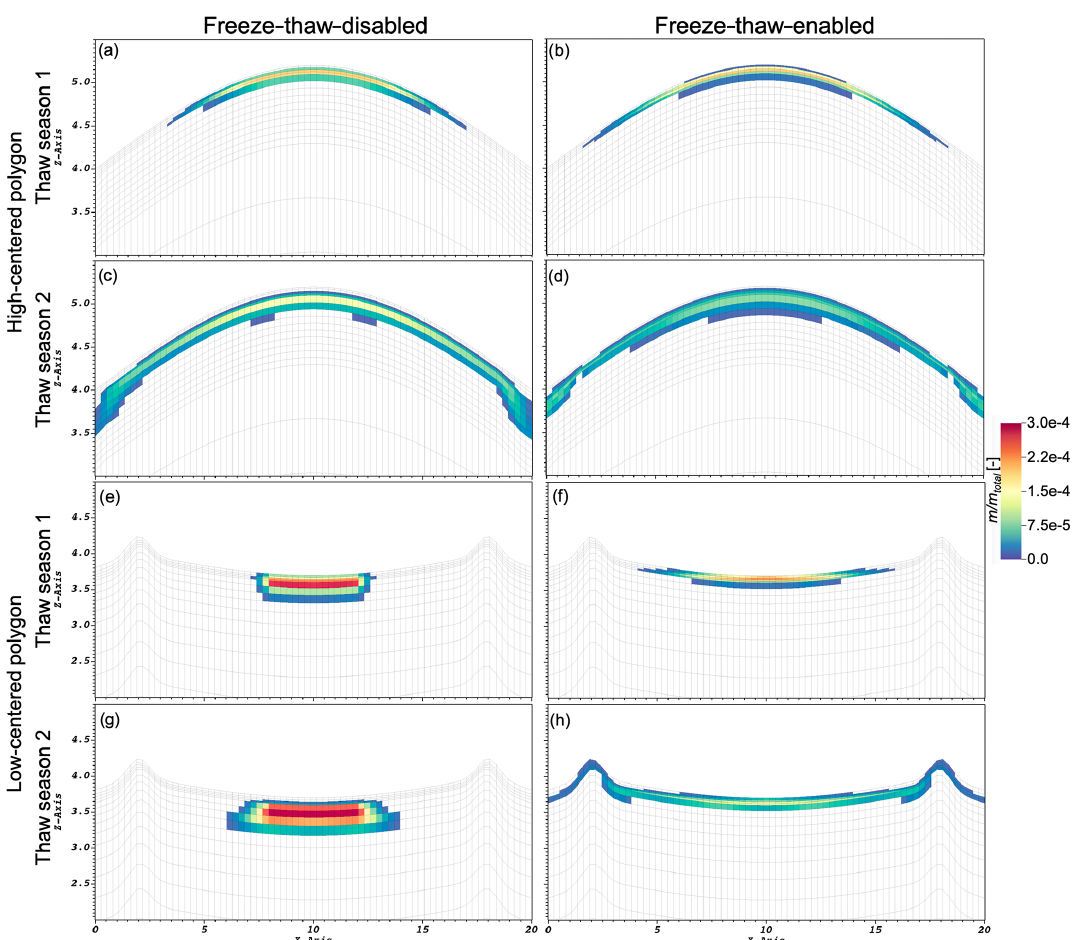
Figure 2. Snapshots of the tracer simulation for the freeze–thaw-disabled (a, c, e, g) and freeze–thaw-enabled (b, d, f, h) cases for the high-centered polygon. The top four plots are for the high-centered polygon, and the bottom four are for the low-centered polygon. The first row (a, b) and the third row (e, f) indicate the end of the first thaw season, and the second row (c, d) and the fourth row (g, h) indicate the end of the second thaw season. The color bar represents the fraction of tracer mass with respect to the total mass injected. Here we do not show m/m total for values less than 10 − 5